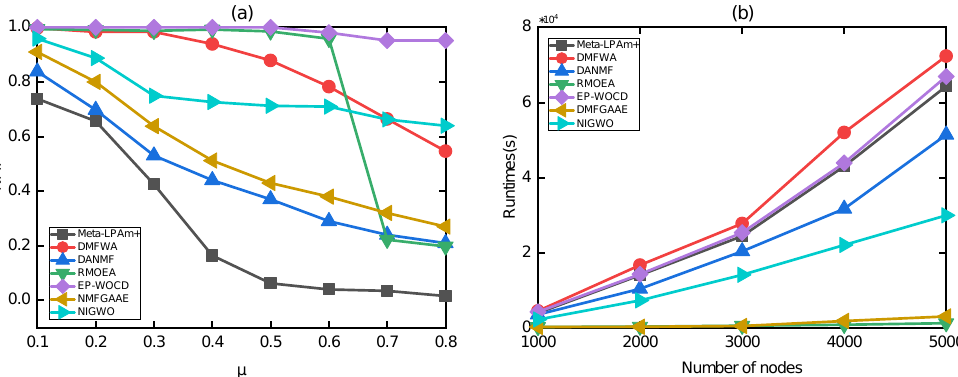
Figure 12. Comparison on LFR networks. ( a ) Comparison of NMI at different µ . ( b ) Comparison of time at different number of